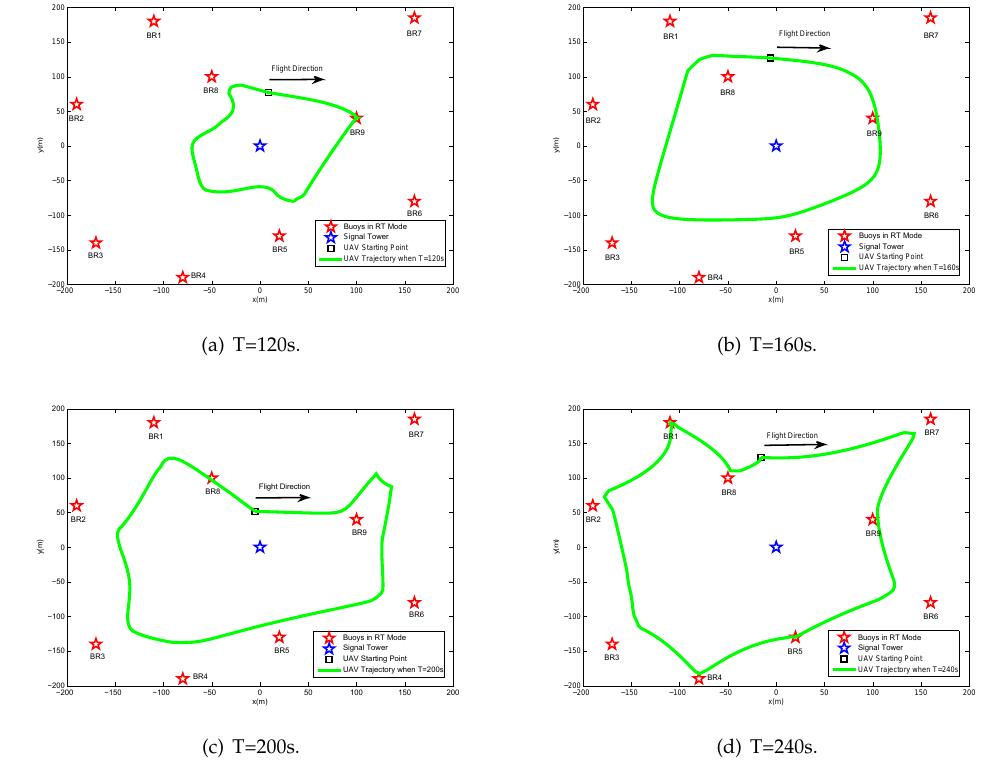
Figure 4. The optimized UAV trajectory for different values of period T for the case B k [ 0 ] =